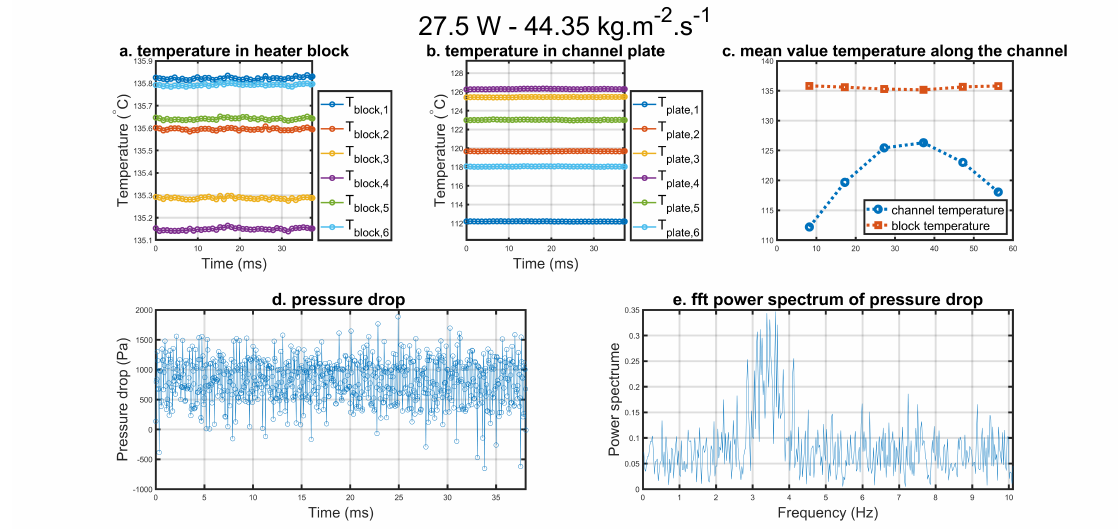
Figure 4. Example of raw data using a heating power of 25 W and a flow of 1